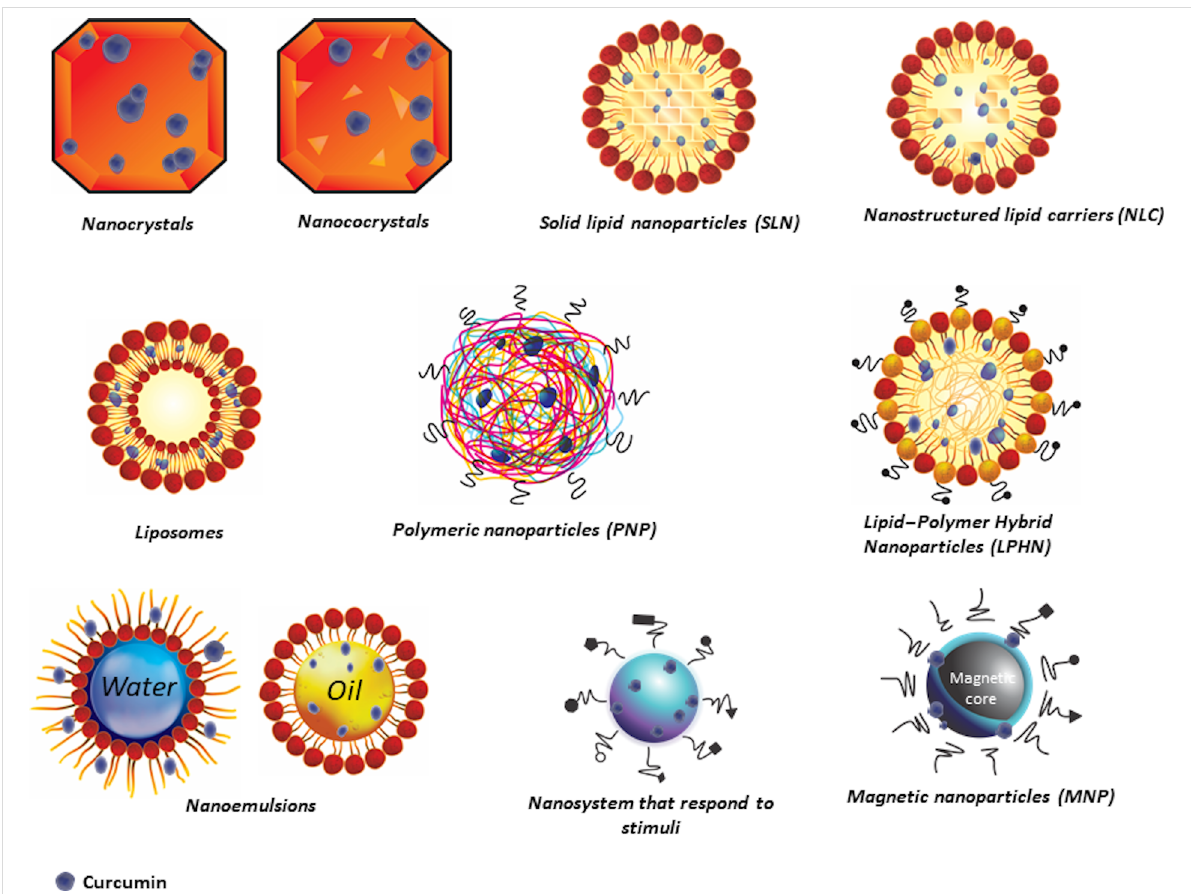
Figure 2: Graphical representation of CUR-based nanosystems. Because of its poor water solubility, CUR will preferentially accumulate in the lipophilic component of the structures, such as the lipid cores or the